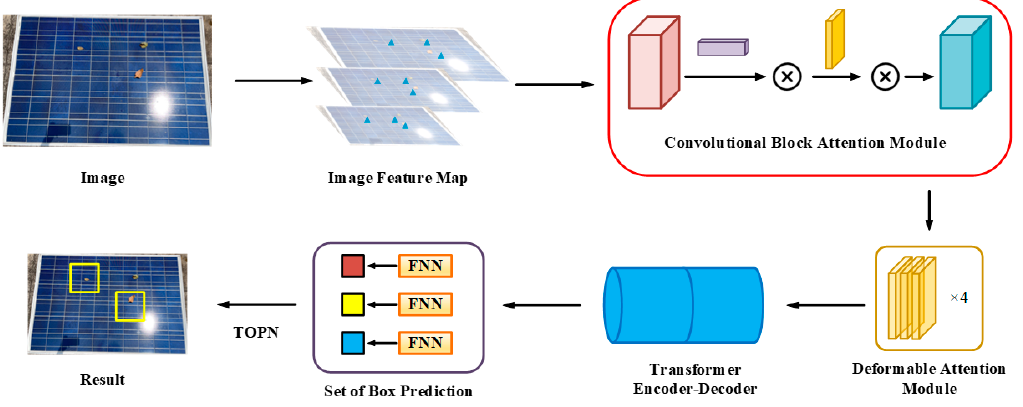
Figure 4. IDETR model